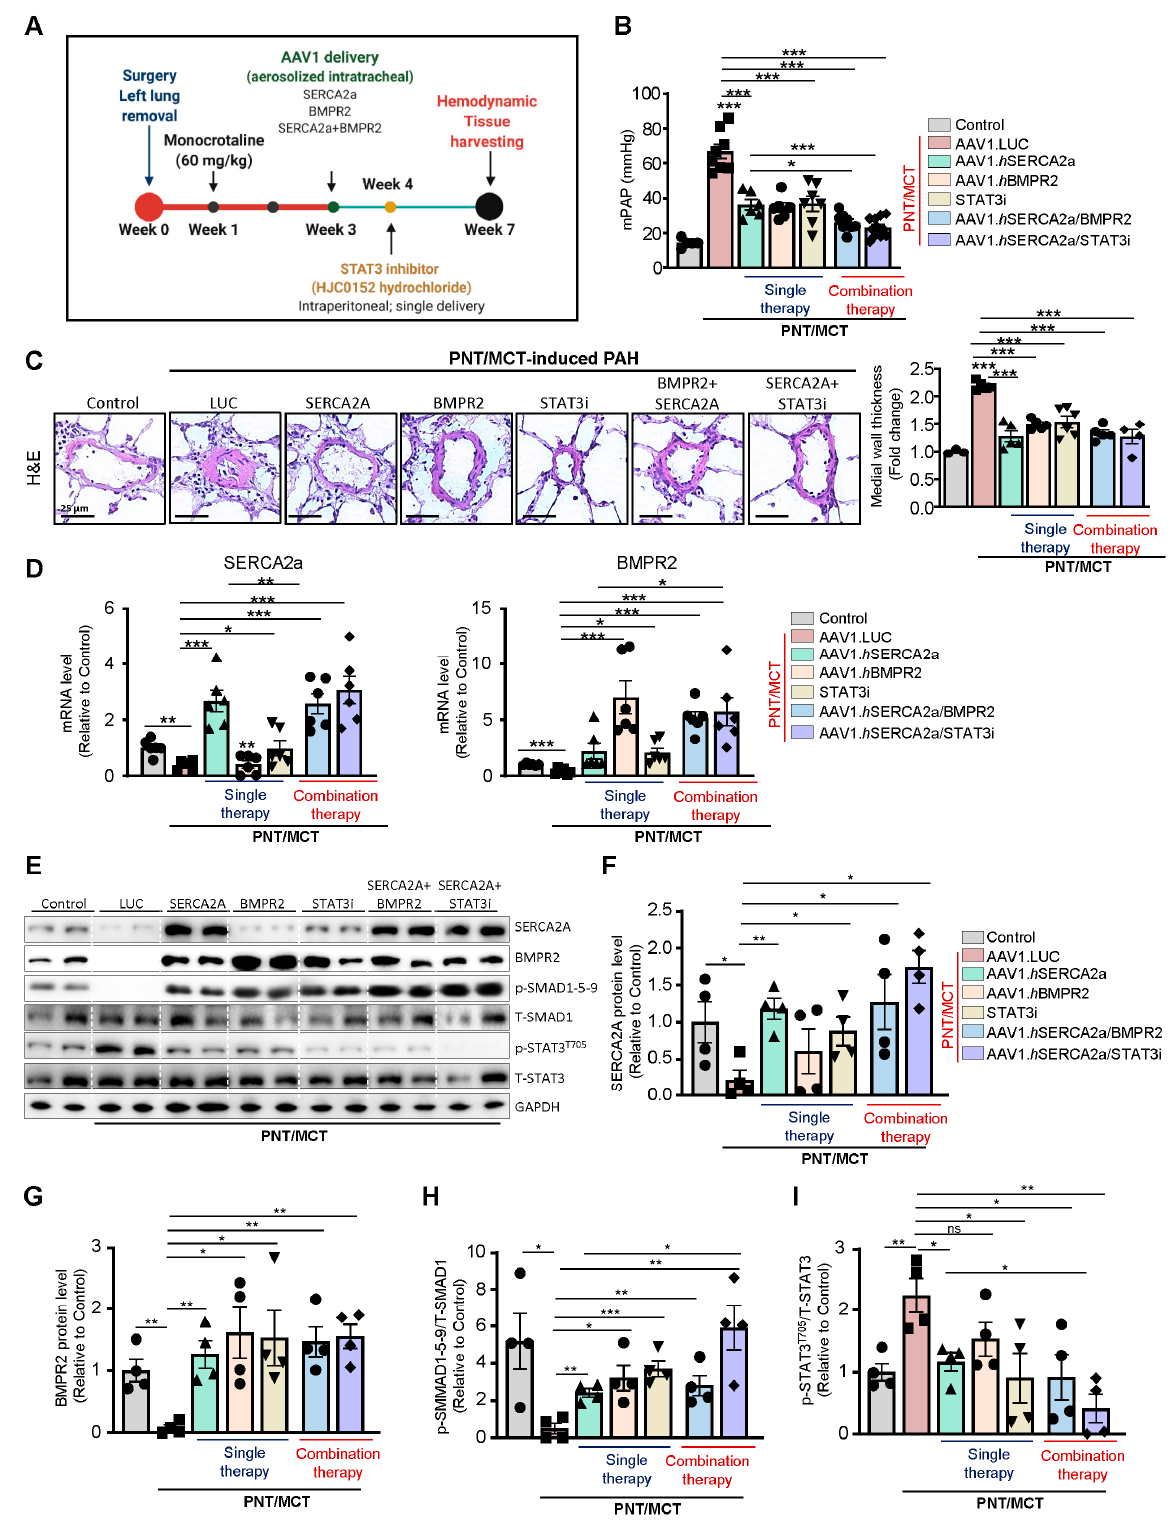
Figure 5. Therapeutic efficacy of single and combination therapy using AAV1-based gene transfer and the STAT3 inhibitor HJC0152 in a severe PAH model. ( A ). Schematic of the experimental design to assess the therapeutic efficacy of single or combination therapy using aerosolized AAV1.LUC, AAV1. h SERCA2a, or AAV. h BMPR2 gene therapy and a STAT3 inhibitor (STAT3i, HJC0152, intraperitoneal injection) in the rat PAH model induced by unilateral left pneumonectomy combined with MCT (PNT/MCT). Tissues were collected at week 7 for molecular and histology analysis. ( B ). Mean pulmonary artery pressure (mPAP) was assessed in control and PNT/MCT-induced PAH in rats that were either treated with AAV1.Luciferase